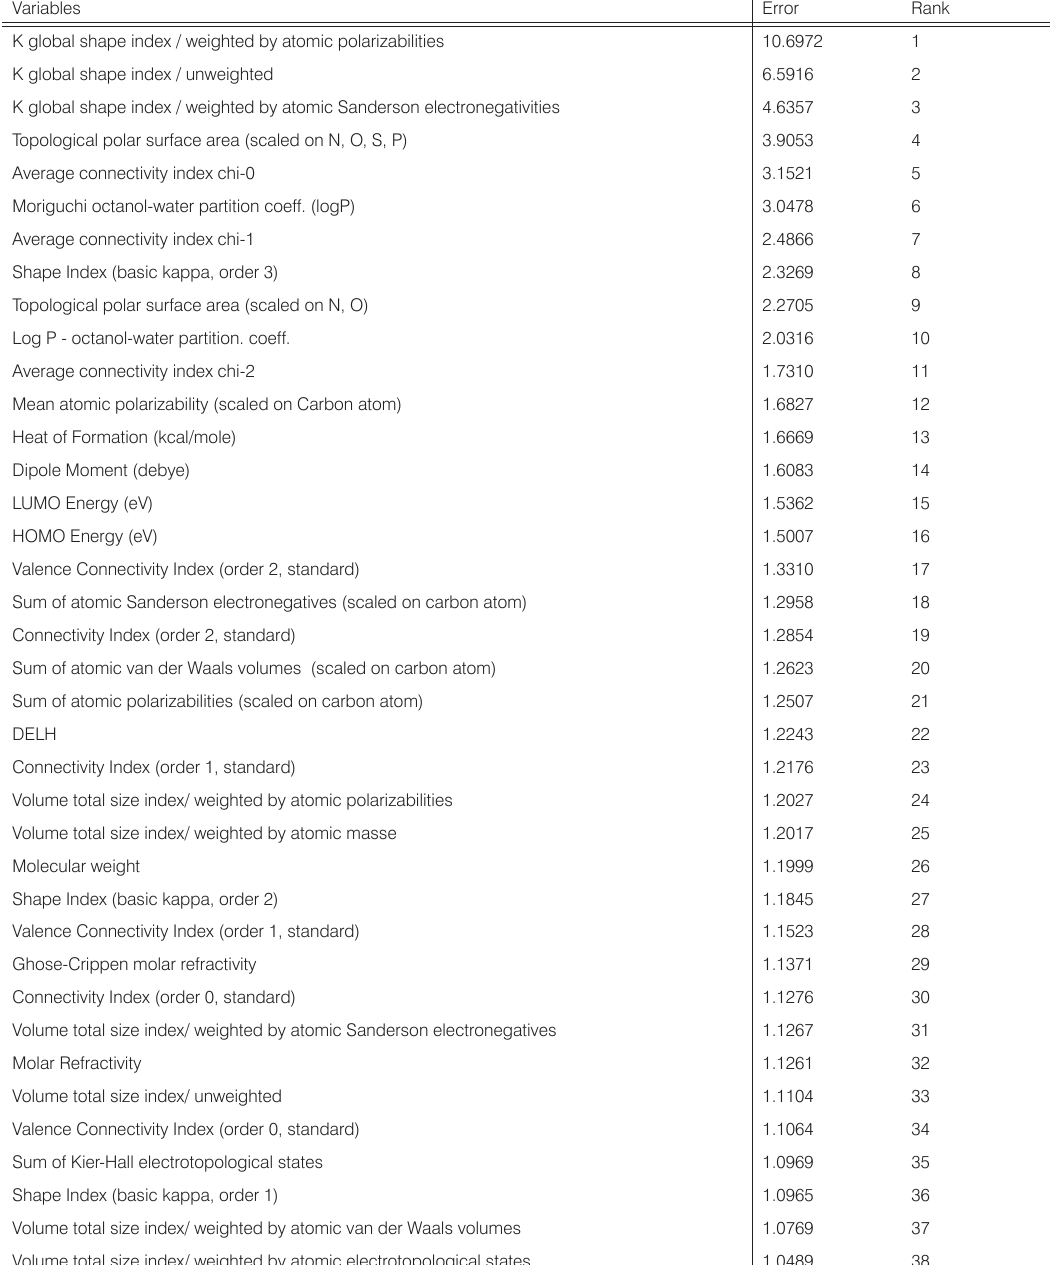
Table 2. Sensitivity